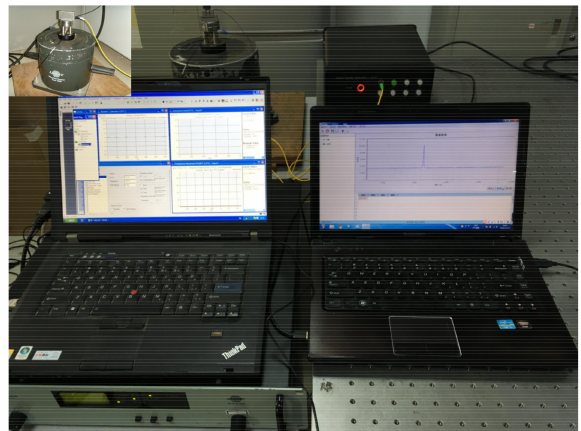
Figure 18. Accelerometer dynamic calibration testing